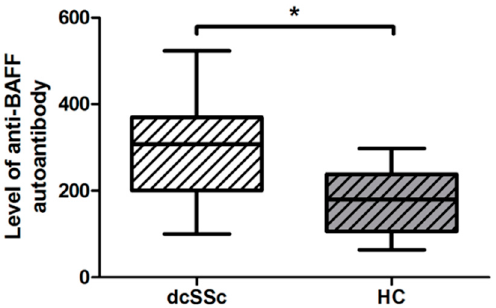
Figure 2. Difference in the serum level of autoantibody directed against BAFF in dcSSc ( n = 20) and HCs ( n = 21), measured by Luminex MAGPIX. The boxes show interquartile ranges (IQR), the horizontal lines represent medians, and the whiskers indicate the lowest and highest values. * p < 0.05.